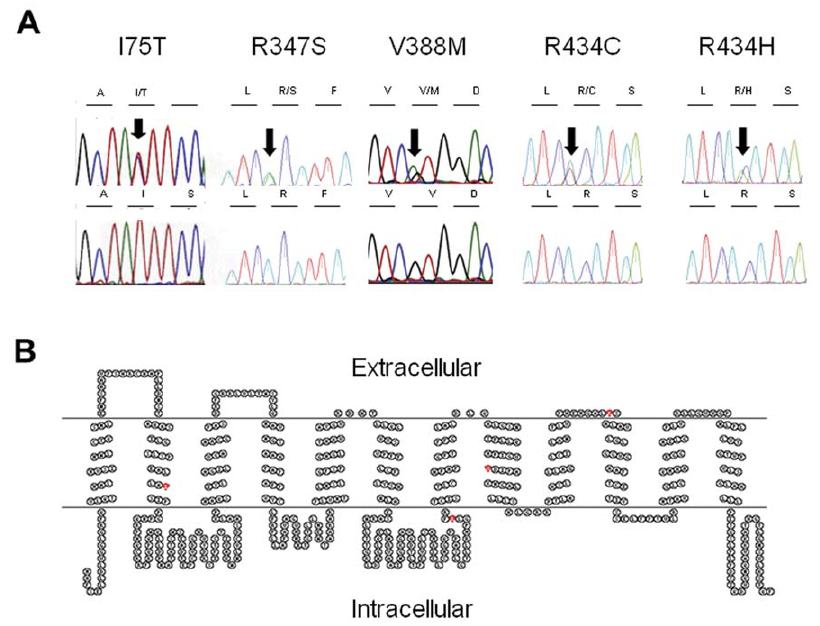
Figure 1. Identification of mutations within SLC22A12 encoding URAT1. A. Chromatograms showing sequence data and translated amino acids. These demonstrate heterozygous missense variants (above, arrowed) and normal controls (below). B. SLC22A12 encodes URAT1, a 553 amino acid protein with a predicted 12 Transmembrane domains (TMPred). It has an intracellular N- and C- terminus. Amino acid residues implicated in hypouricaemia and modelled in the present study are highlighted in red and include Isoleucine, I at position 75, arginine, R at position 347, Valine V at position 388 and Arginine, R at position 434.